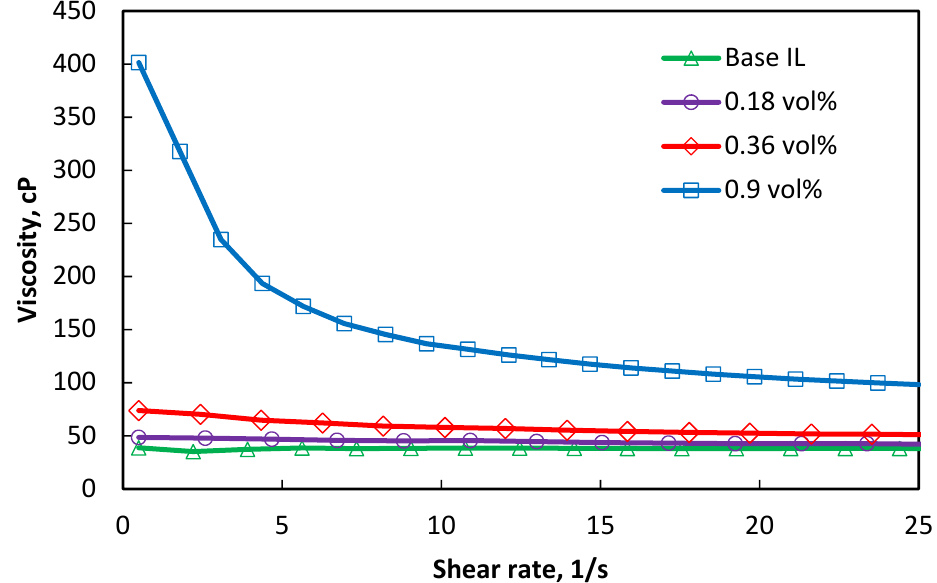
Figure 18. Rheological behavior of [C 4 mim][NTf 2 ] ILs and Al 2 O 3 nanoparticles enhanced nanofluids at 25 °C [49]. Reproduced with permission from [Paul], [Int. J. Heat Mass Transf.]; published by [Elsevier], 2015.